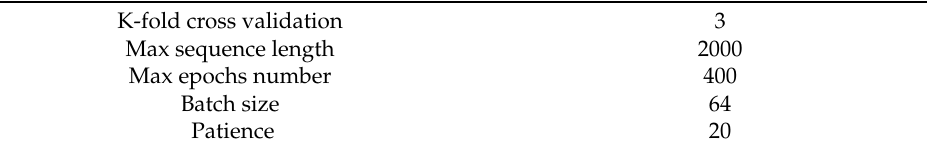
Table 3. General hyperparameters.